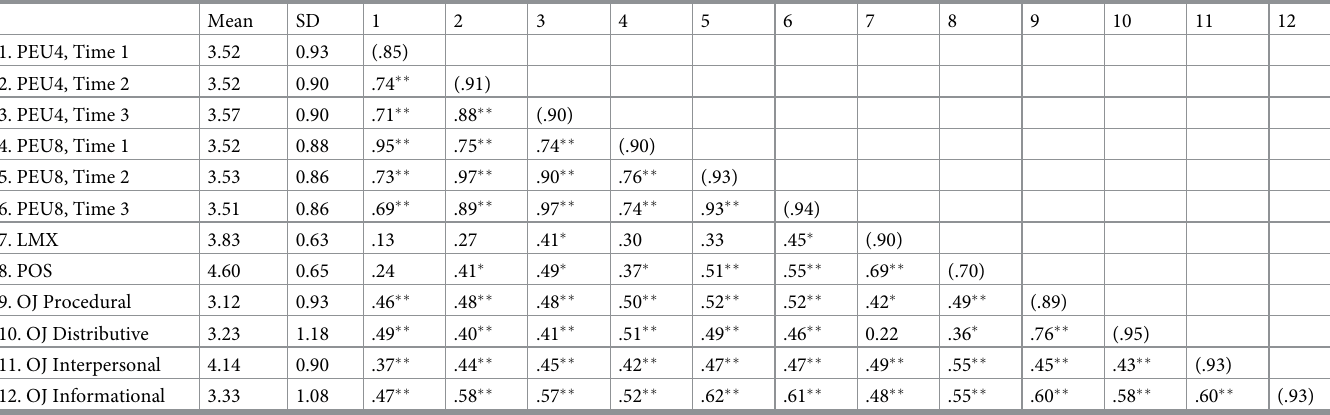
Table 4. Descriptive statistics, correlations, discriminant validity reliabilities of PEU, LMX, POS, OJ (Studies 2 and 4).